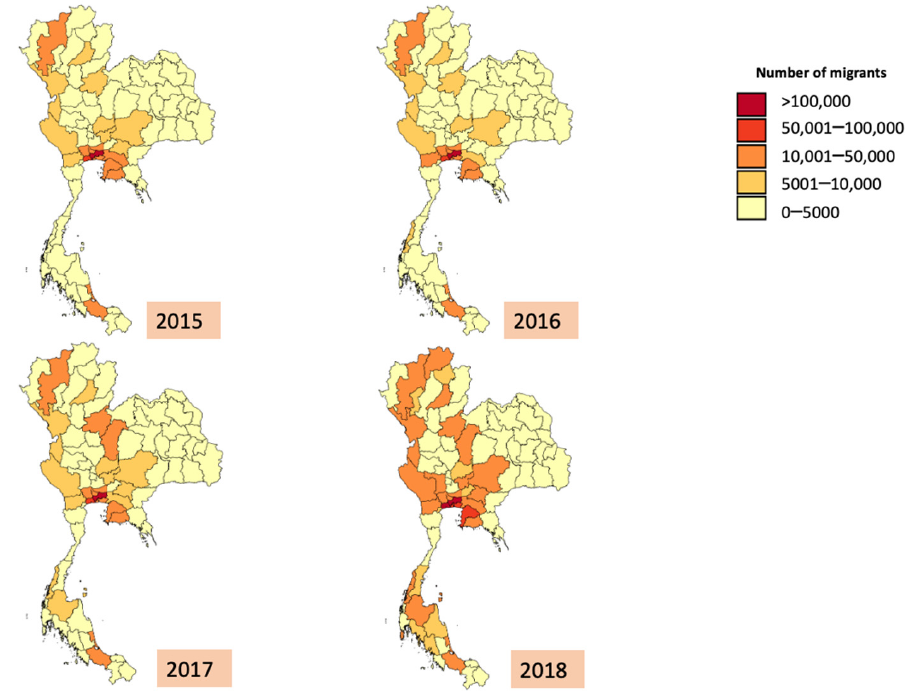
Figure 1. Geographical Difference of migrants’ SSS insurees number, 2015–2018.